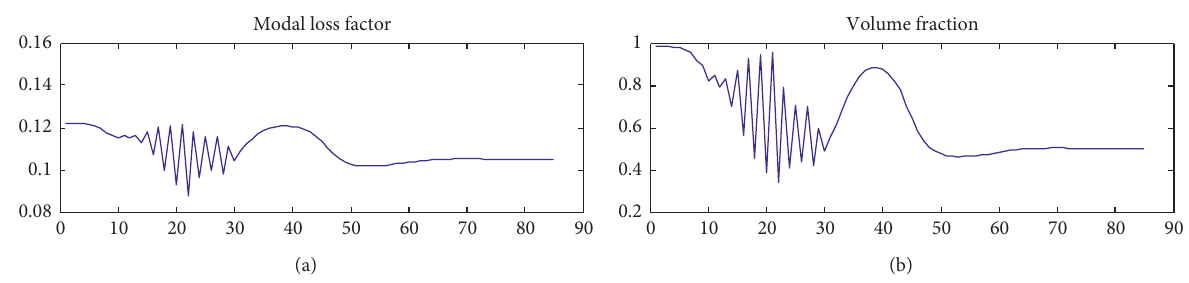
Figure 12: Convergence curves of the modal loss factor (a) and volume fraction (b) of the damping layer for the 5th modal with one hole as the initial design ( τ � 0 .